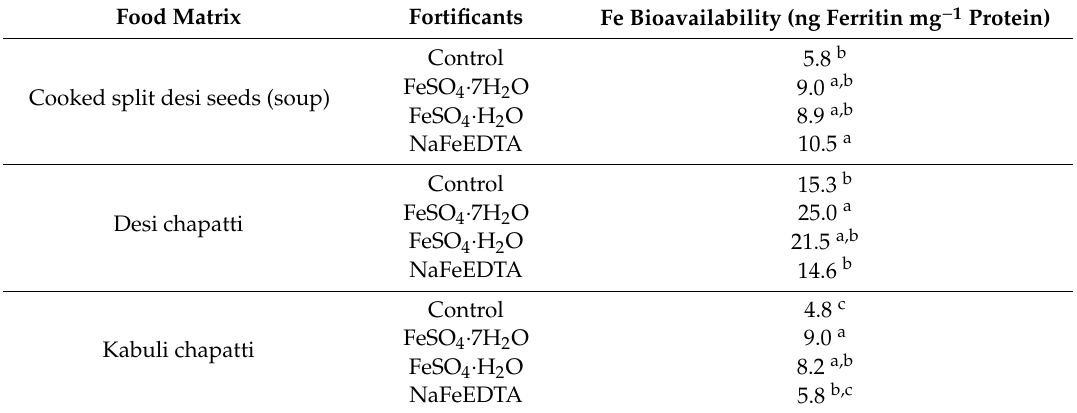
Table 2. The interaction e ff ects between food matrices (cooked split desi seeds (soup), desi chapatti and kabuli chapatti) and fortificants (FeSO 4 · 7H 2 O, FeSO 4 · H 2 O and NaFeEDTA) on Fe bioavailability (ng ferritin mg − 1